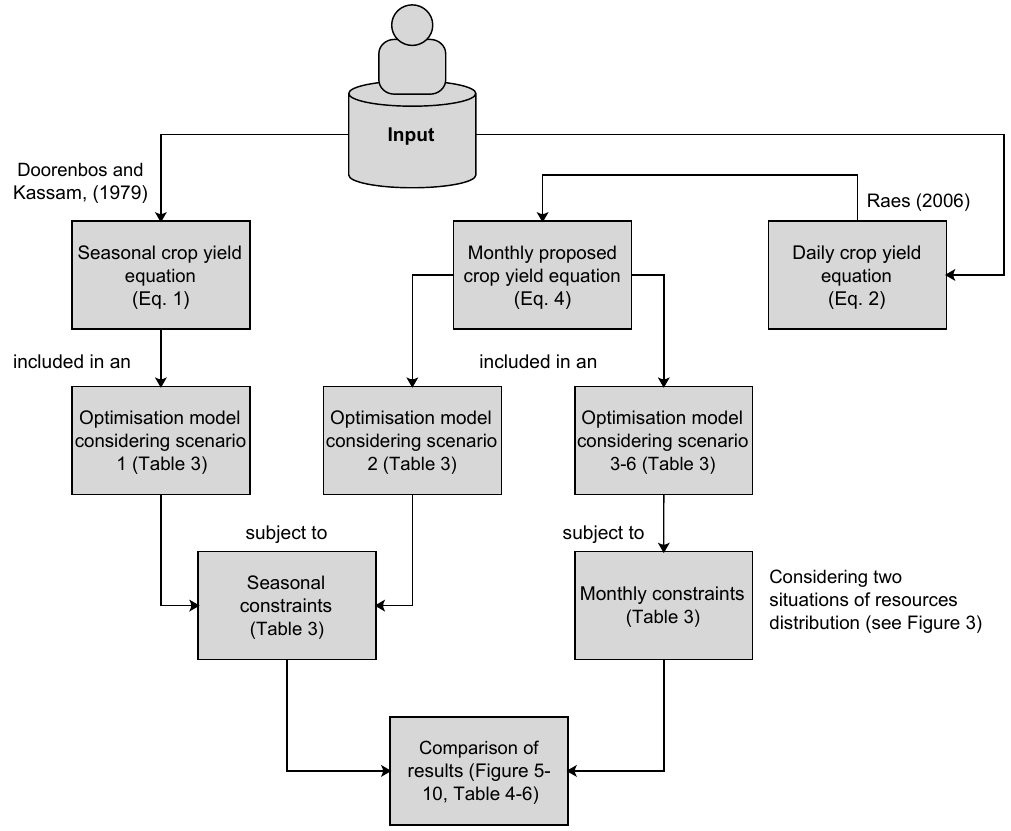
Figure 4. Methodology used for this research. The six scenarios were assessed by two situations of time and resource